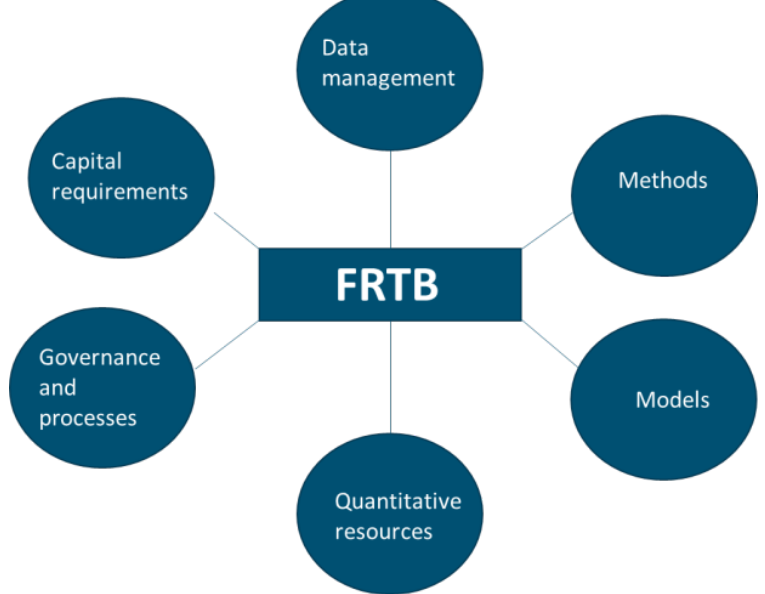
Figure 1. Analysis of current systems.